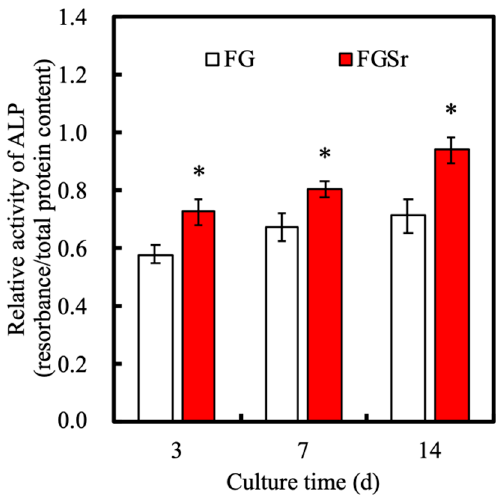
Figure 10. ALP profile of the WJMSCs-laden FG and FGSr scaffolds in osteogenic differentiation medium. “*” indicates a significant difference ( p < 0.05) when compared to FG.